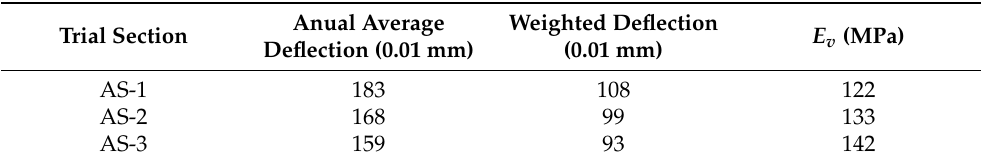
Table 8. Modulus of the compressibility mean in each